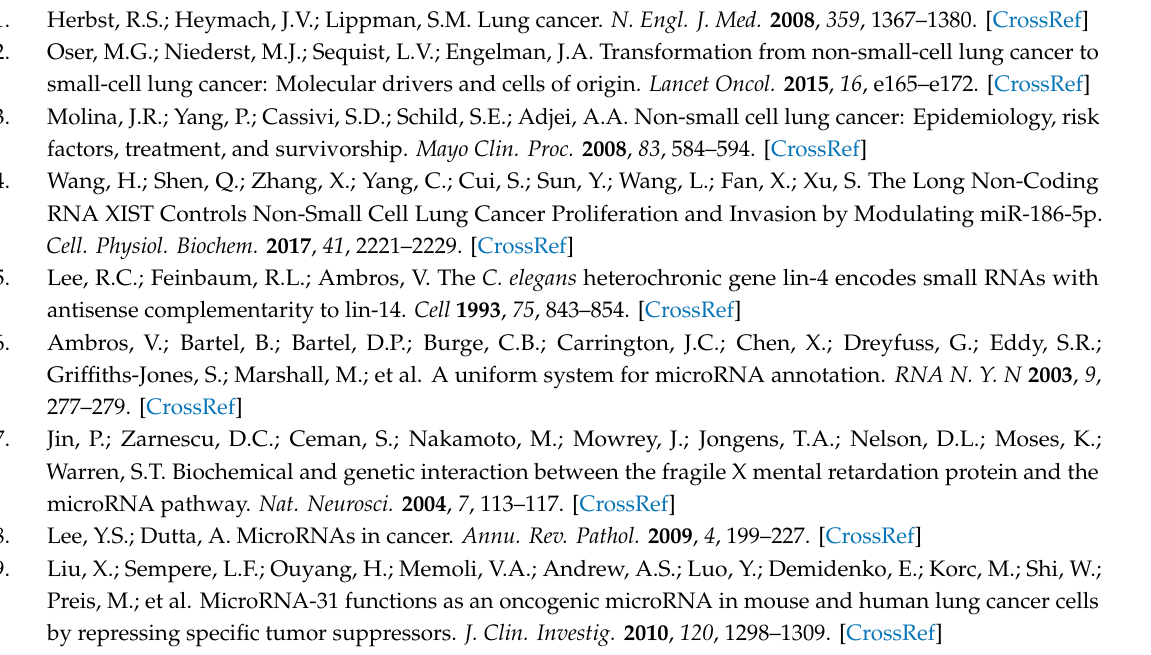
Table S1: List of meta-DEGs; Table S2: List of significantly enriched GO terms for the identified PPI cluster genes; Table S3: List of significantly enriched pathways for the identified PPI cluster genes; Figure S1: [A] Analysis of scale-free fitting indices (Rˆ2) for various possible soft-thresholding powers ( β ). [B] Analysis of mean connectivity for various possible soft-thresholding powers ( β ). [C] Histogram of network connectivity distribution when β = 16. [D] log _10 (k) vs log _10 (p(k)) plot of the same histogram where the scale-free topology is depicted by the approximate straight line relationship (high Rˆ2 = 0.80) and a negative value of slope (slope = − 1.32). Figure S2. Correlation plots of k.in (x-axis) vs. MM (y-axis) for [A] brown, [B] blue, and [C] green modules, respectively. The color indicates the module and the dots indicate the genes within that module. After raising the MM to β , it is highly correlated with k.in for all the